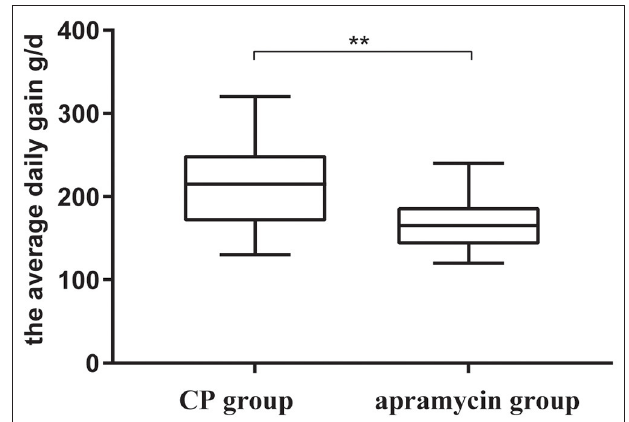
FIGURE 2 | The average daily gain of the calves at enrollment and exit received a twice daily oral dose of 100ml per time of CP or a twice daily oral dose of 12 mg/kg per time of apramycin, ** p < 0.01.